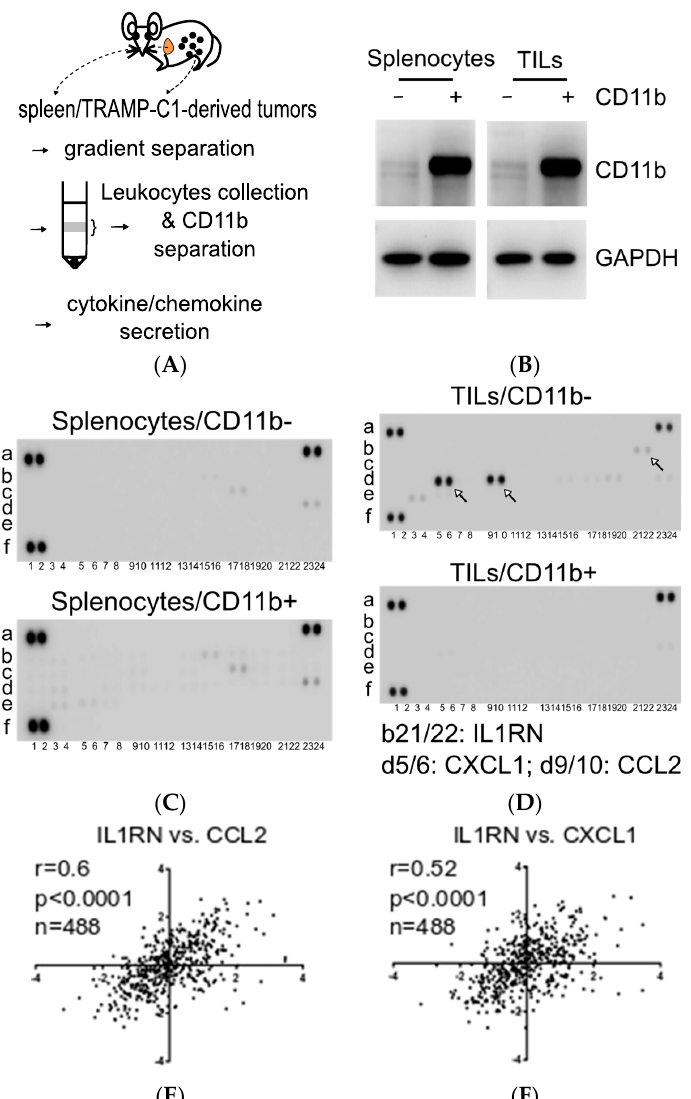
Figure 2. Association of interleukin-1 receptor antagonist (IL1RN) with cluster of differentiation 11b (CD11b)-deficient (CD11b − ) tumor-infiltrating leukocytes (TILs) in the transgenic adenocarcinoma of the mouse prostate (TRAMP)-C1-derived tumor microenvironment (TME). ( A ) Outline for analyzing cytokine/chemokine profiles of leukocytes. Single-cell suspensions prepared from the spleen (orange) or tumors were separated by a Ficoll gradient to enrich leukocytes followed by CD11b-positive cell isolation using an immunomagnetic approach. Secreted factors in conditioned media from different populations were analyzed. ( B ) Characterization of CD11b-negative ( − ) and -positive (+) populations from splenocytes and TILs. Cell lysates were analyzed by Western blotting. ( C ) Comparison of cytokine/chemokine profiles of CD11b − and CD11b + populations from splenocytes. ( D ) Comparison of cytokine/chemokine profiles of CD11b − and CD11b + populations from TILs. Selected factors were labeled with white arrows (IL1RN, CXCL1, and CCL2). ( E , F ) Correlation of the human IL1RN with CCL2 and with CXCL1. mRNA expression z-scores were plotted on a log-scale. Gene expressions from a human prostate adenocarcinoma database, The Cancer Genome Atlas (TCGA) Program, were analyzed on the website cBioPortal for Cancer Genomics.